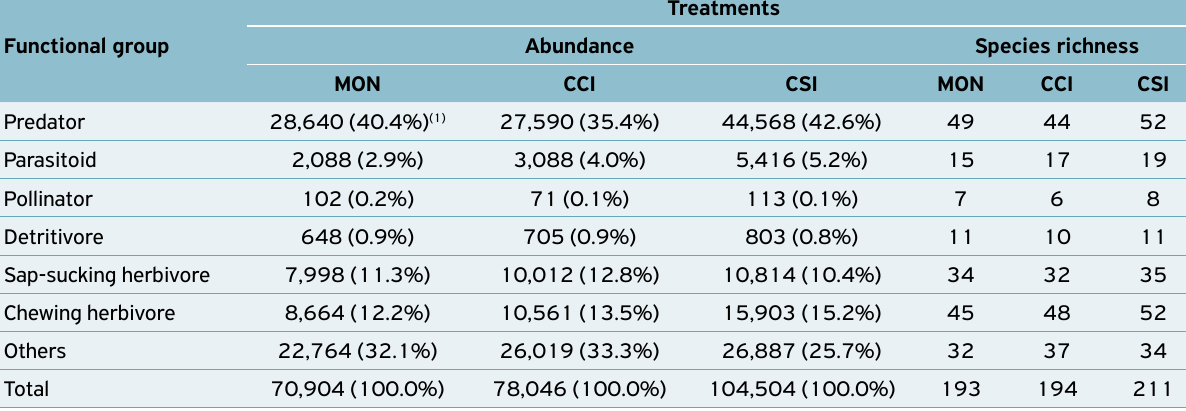
Table 2. Abundance and species richness by functional group for the treatments genetically modified maize and conventional maize with and without insecticide sprays in Ponta Grossa, PR,